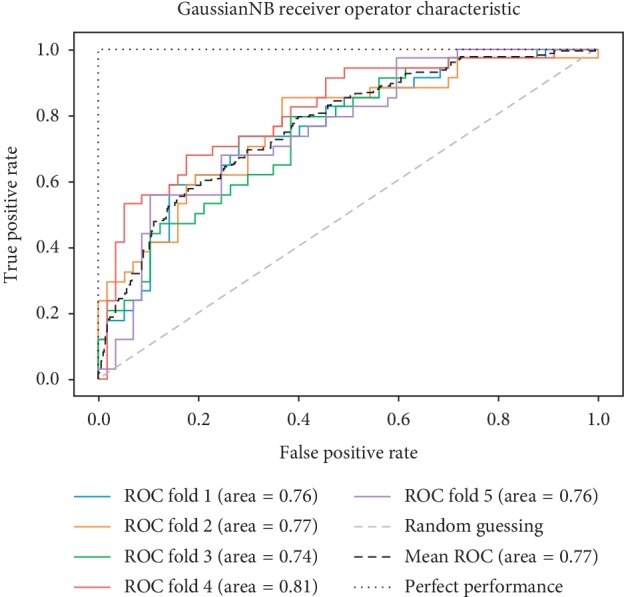
ROC curve for GNB.